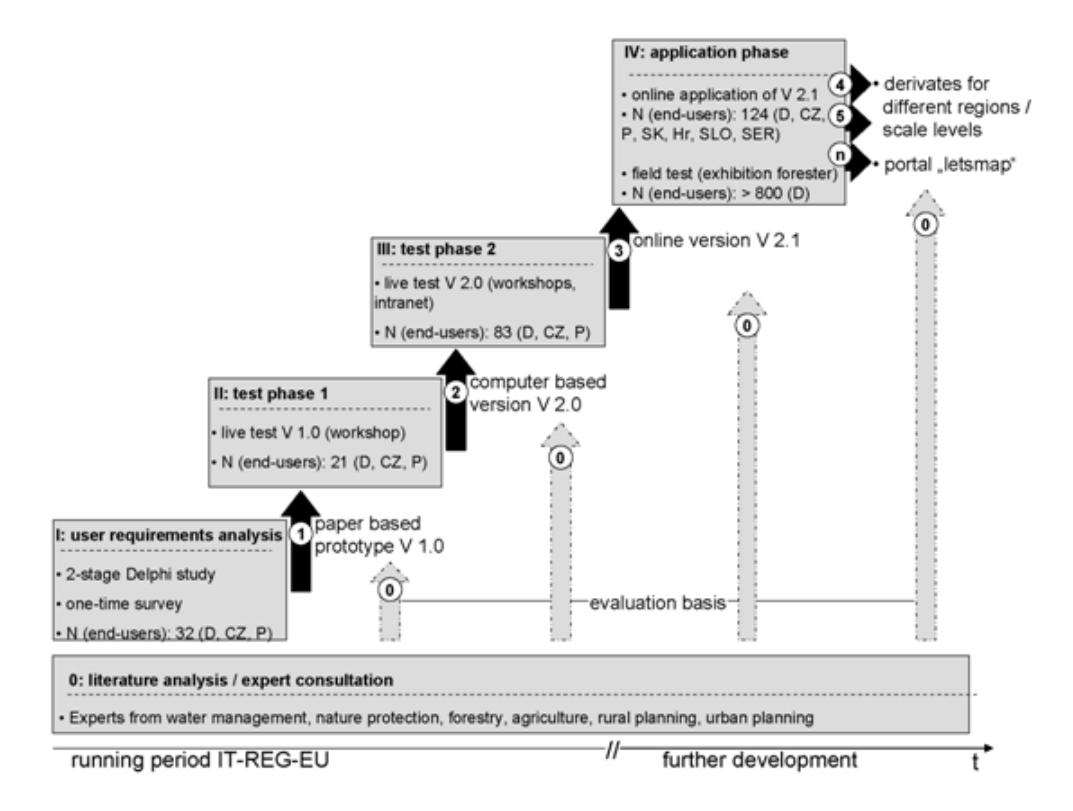
Fig. 1 . Development process of Pimp your landscape . Most working steps overlapped to ensure an intensive feedback between tests and technical